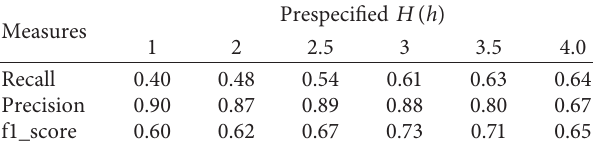
Table 5: Failure prediction results with interval